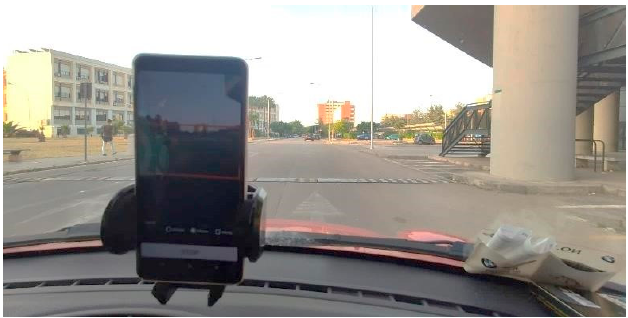
Figure 4. Image depicting smartphone setup during surveys.